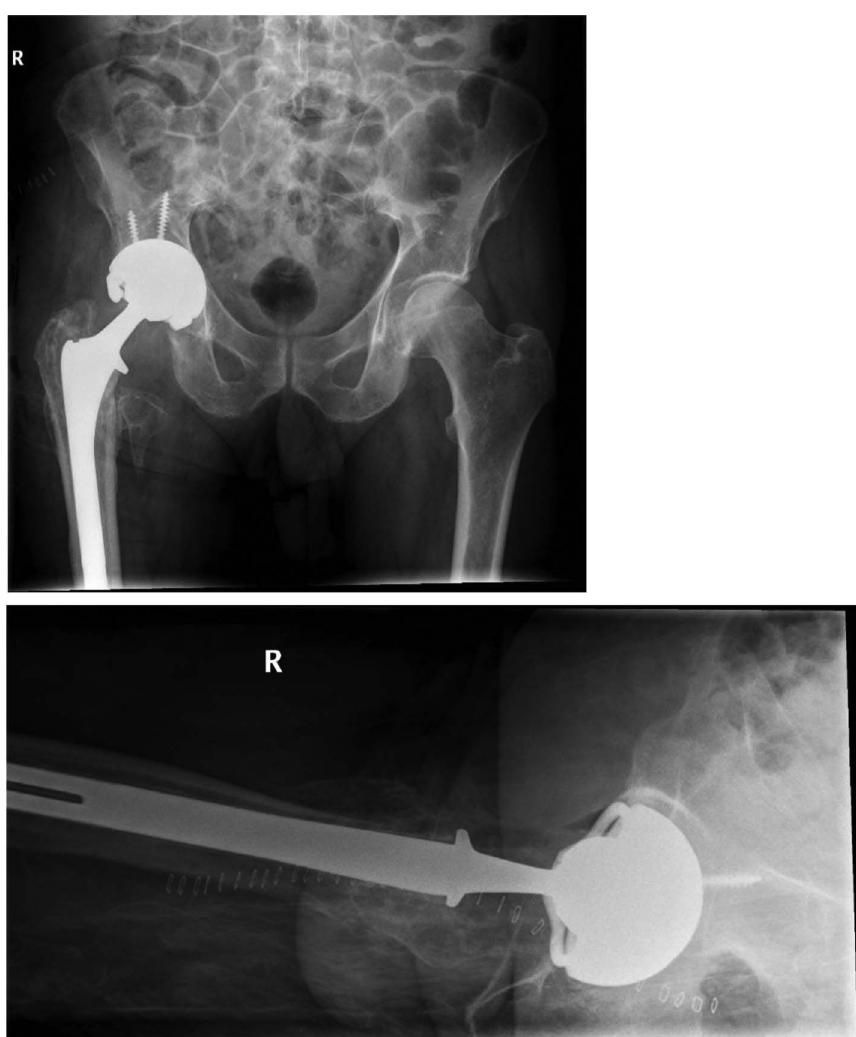
Figure 6. A and B: Constrained liner following the 2nd revision